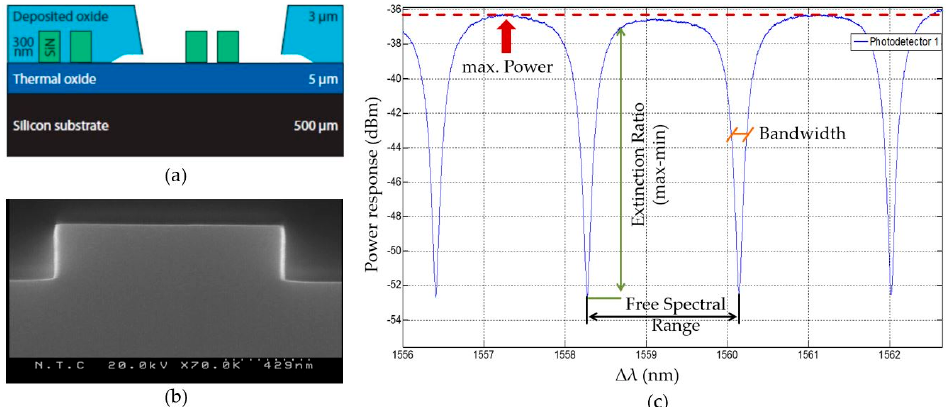
Figure 1. Manufacturing and characterization methodologies used for the fabrication of the photonic sensor: ( a ) cross-section showing the final layer structure of a photonic sensor with optical waveguides secured by an oxide and optical ring resonators in contact with the surrounding environment; ( b ) SEM picture of optical waveguides within silicon nitride. SEM images are done for technical characterization reasons of the single features by spot testing; and ( c ) response signal of an exemplary optical ring resonator. The included labels refer to central parameters describing the performance of each resonator.